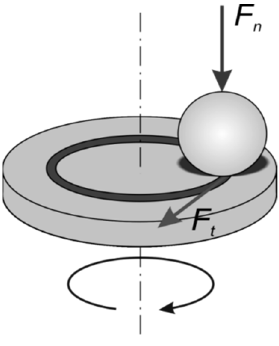
Figure 1. Ball-on-disc geometry of the friction–wear